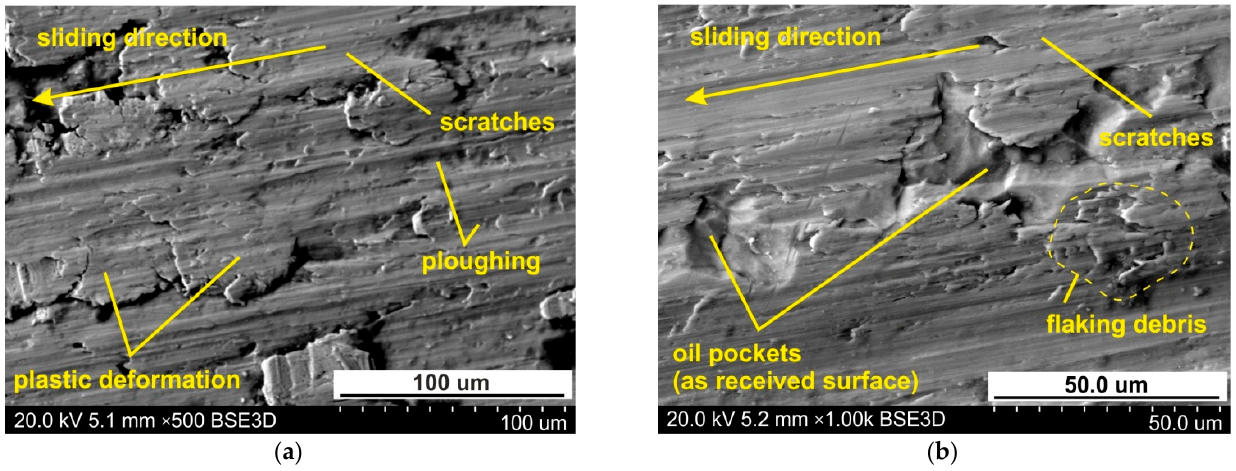
Figure 10. The specimen surfaces tested at 96 MPa in ( a ) dry friction and ( b ) lubricated conditions using engine oil 10W-40.